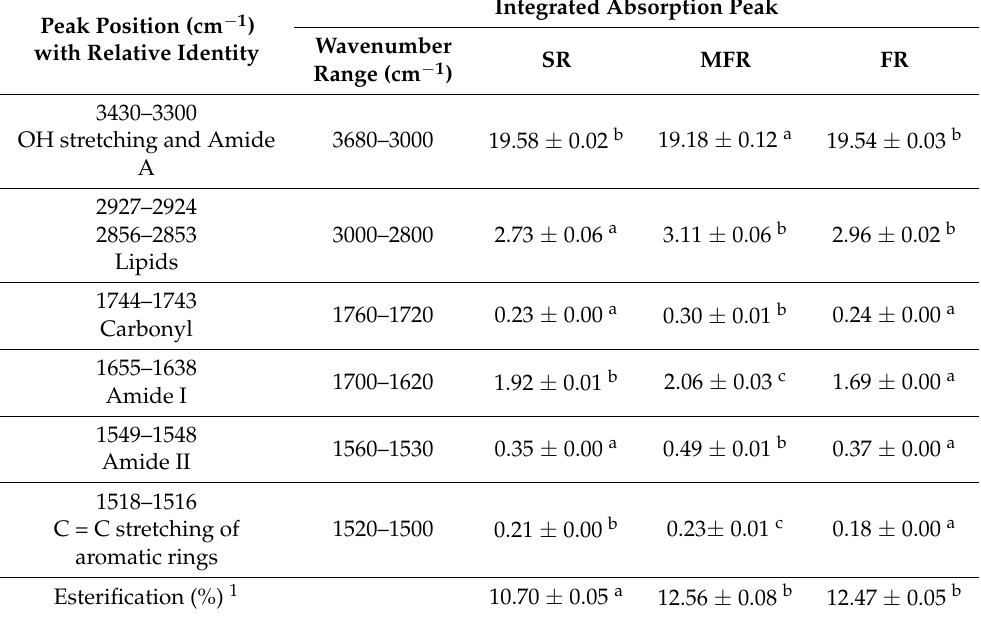
Table 2. Integrated absorption peaks for the FTIR spectra of the root samples collected from 2-day-old germinating seeds and esterification